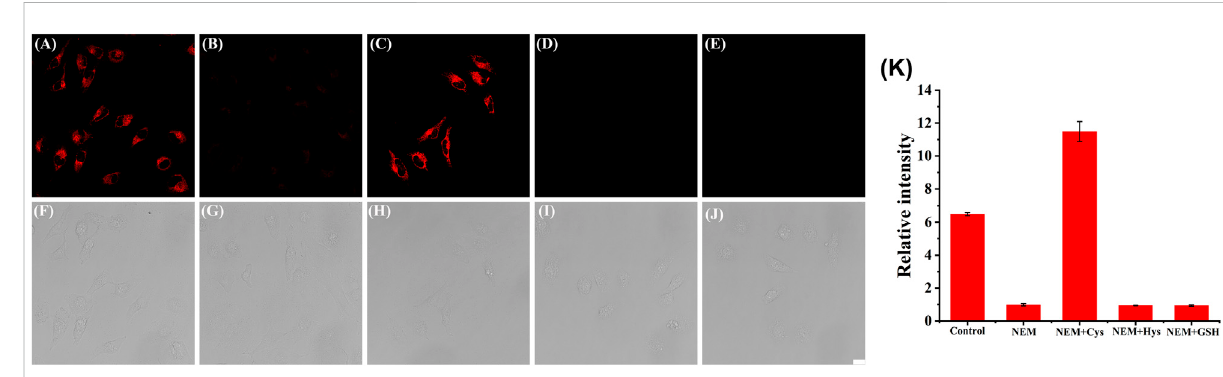
FIGURE 3 CLSM images of Panc-1 cells treated with (A,F) Cy-Cys-pH (5 μ M), (B,G) NEM (10 μ M), (C,H) Cys (100 μ M) with NEM, (D,I) Hcy (100 μ M) with NEM, and (E,J) GSH (100 μ M) with NEM. (K) The corresponding histogram of the fl uorescence intensities from the images in (A – E) . λ ex = 638 nm,